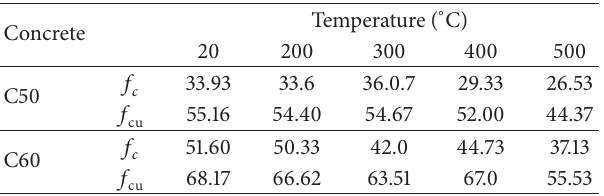
Table 3: The compressive strength and cubic compressive strength of HPC at elevated temperature